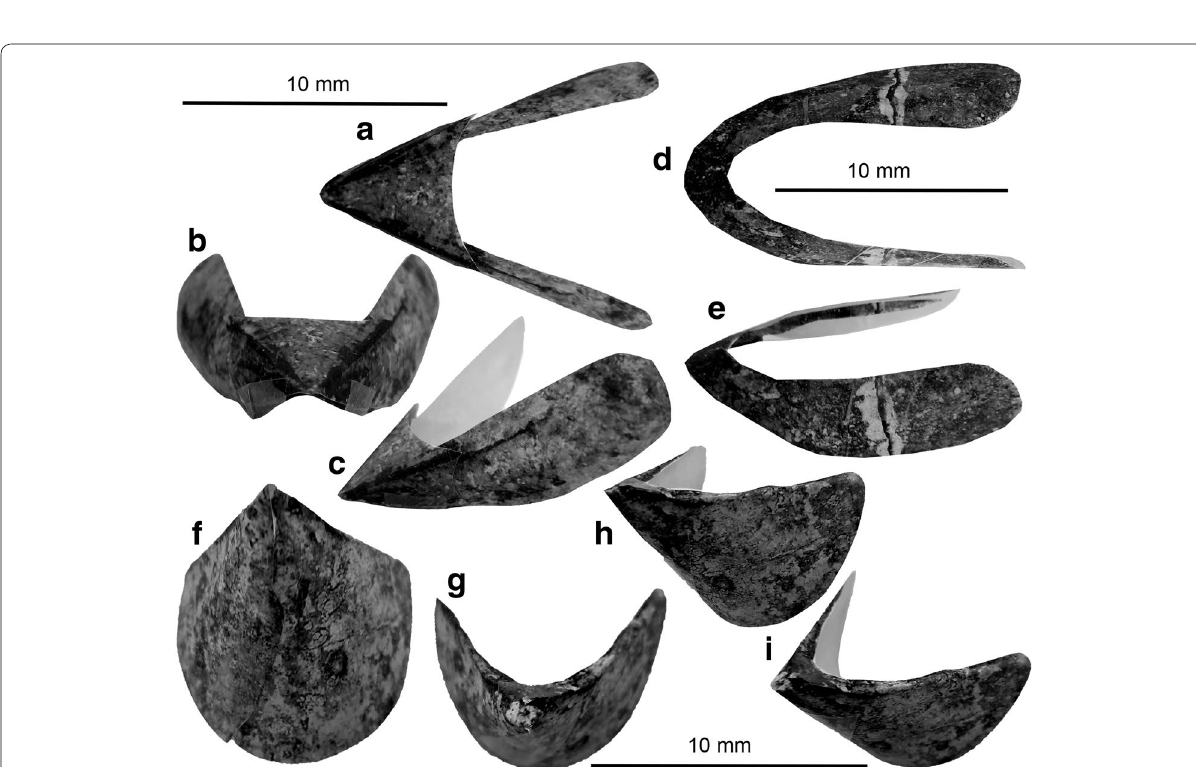
Fig. 6 Paper reconstructions of some cephalopod jaws from the Maastrichtian of Greece. We printed the enlarged photos of the jaws, cut them out and taped them where they had ripped due to some taphonomic process (transport, compaction or else). a – c Ammonite upper jaw, maybe from a desmoceratoid, reconstructed after SGL1_4. d , e Teudopsein lower jaw, reconstructed after SGL1_35. f to i Lower jaw of the anaptychus type, maybe from a desmoceratoid,